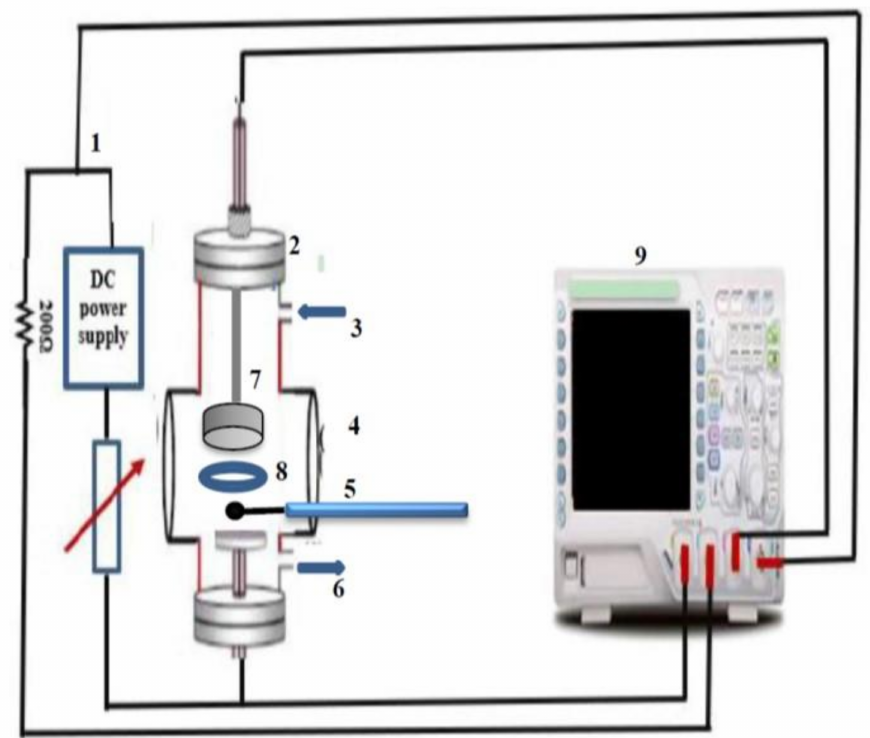
Figure 1. Schematic diagram of the experimental set-up of ( 1 ) DC glow discharge circuit, ( 2 ) evacuated chamber, ( 3 ) gas inlet, ( 4 ) window, ( 5 ) single probe, ( 6 ) rotary pump, ( 7 ) the plasma cell electrodes, ( 8 ) sample holder, and ( 9 )